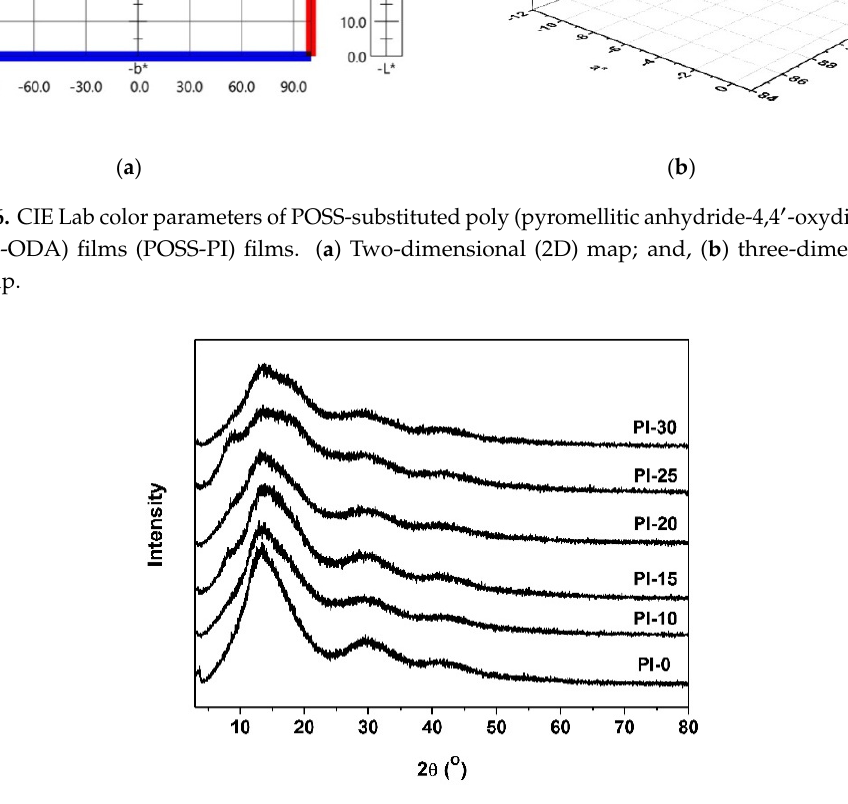
Figure 7. X-ray di ff raction (XRD) patterns of POSS-PI Figure 7. X ‐ ray diffraction (XRD) patterns of POSS ‐ PI films. Figure 7. X ‐ ray diffraction (XRD) patterns of POSS ‐ PI films. Table 2. Optical, thermal, and tensile properties of PI films. Table 2. Optical, thermal, and tensile properties of PI films.